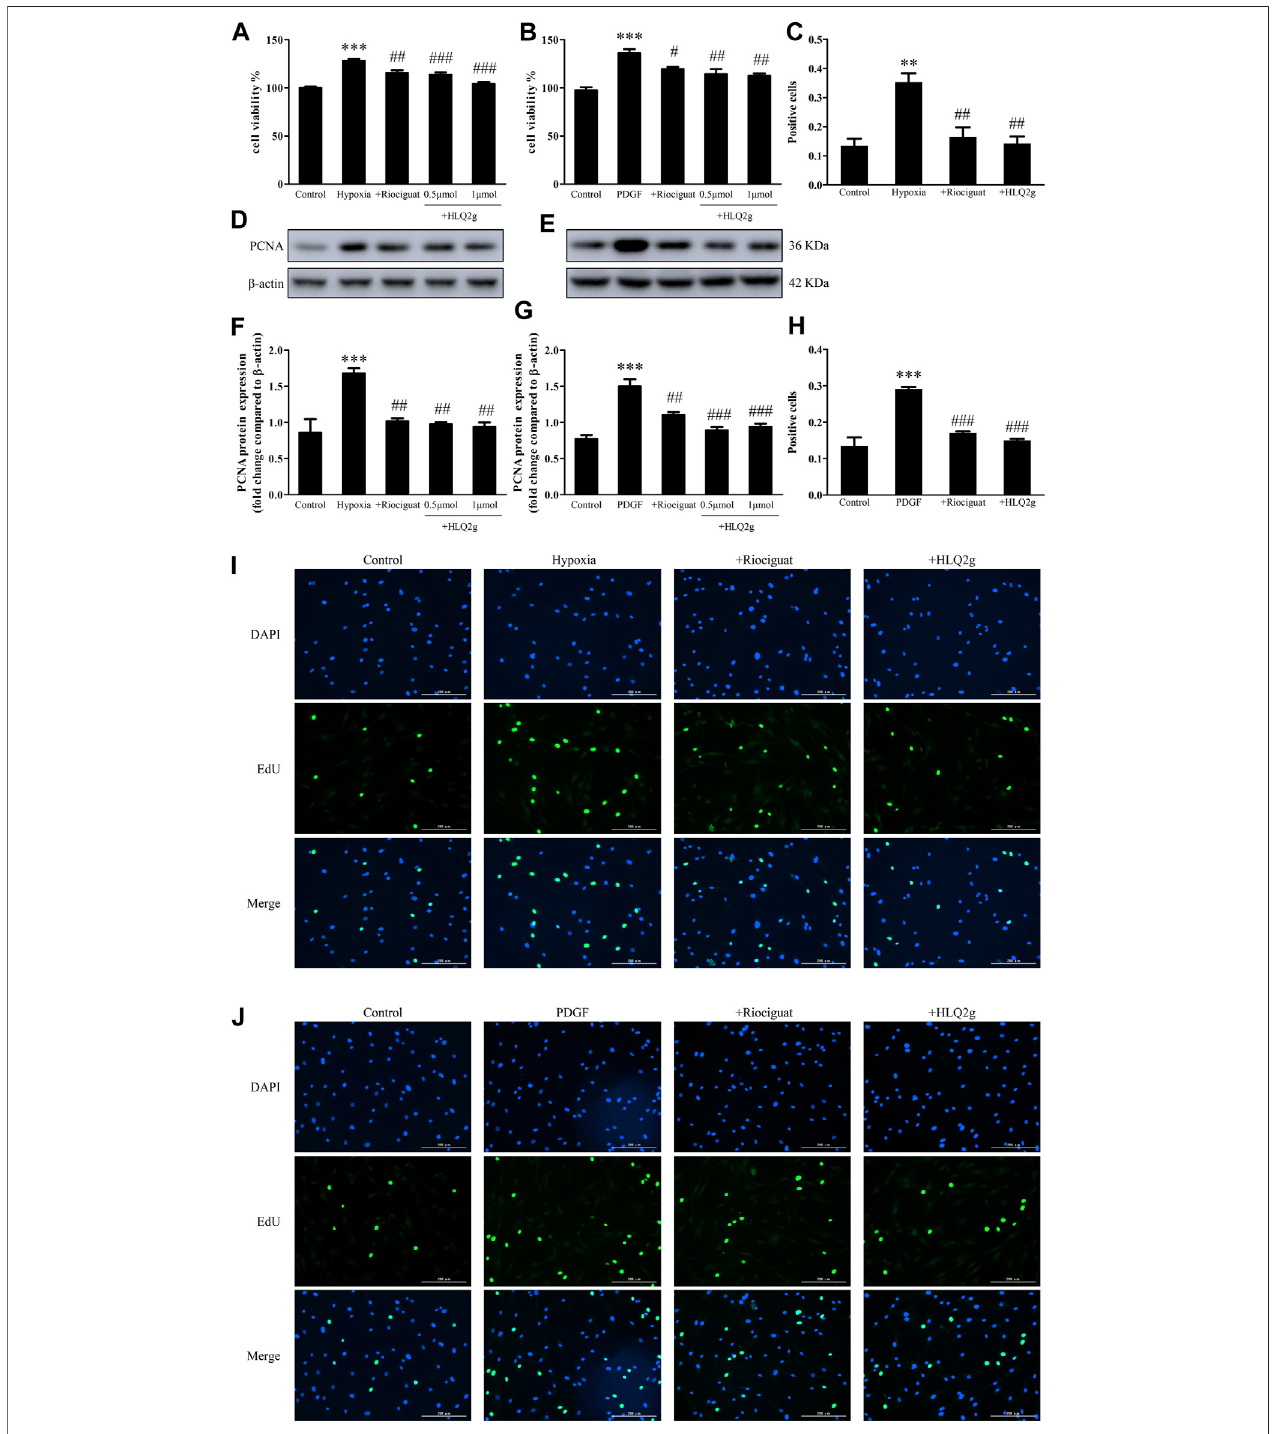
FIGURE 4 | HLQ2g can inhibit the proliferation of HPASMCs. (A, B) : CCK8 detected cell proliferation. (C) : Quantitative analysis of I. (D) : The expression of PCNA protein in HPASMCs stimulated by hypoxia. (E) : The expression of PCNA protein in HPASMCs induced by PDGF. (F) : Quantitative analysis of D. (G) : Quantitative analysis of E. H : Quantitative analysis of J. (I, J) : EdU detected cell proliferation. Riociguat (1 μ M); HLQ2g (1 μ M); Vehicle : 1% DMSO; Control : normal control group; PDGF :platelet-derivedgrowthfactorBBtreatmentgroup(20 ng/ml;24 h).Dataareexpressedasmean ± SD, n (cid:1) 3 – 5.Vs.thecontrol,** p < 0.01,*** p < 0.001;vs. the PDGF/Hypoxia group, # p < 0.05, ## p < 0.01, ### p < 0.001.